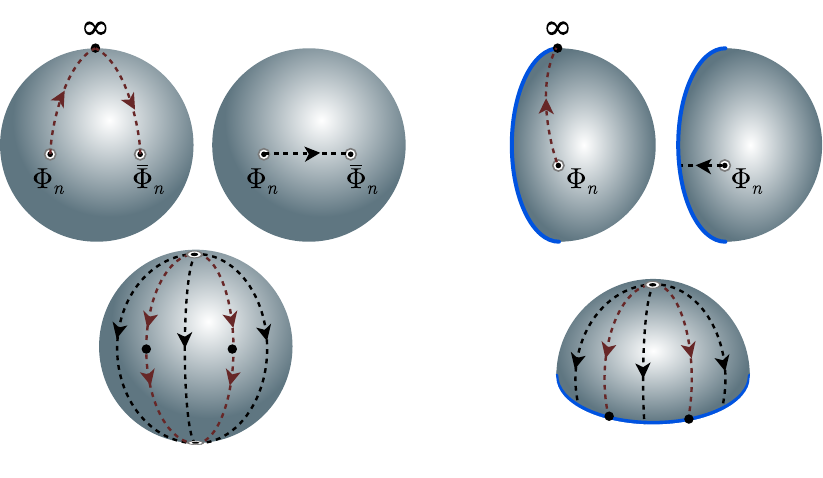
Figure 7 . Left . Deforming the contour of the fundamental domain of R n for a CFT. Right . Performing the equivalent deformation on R n for a